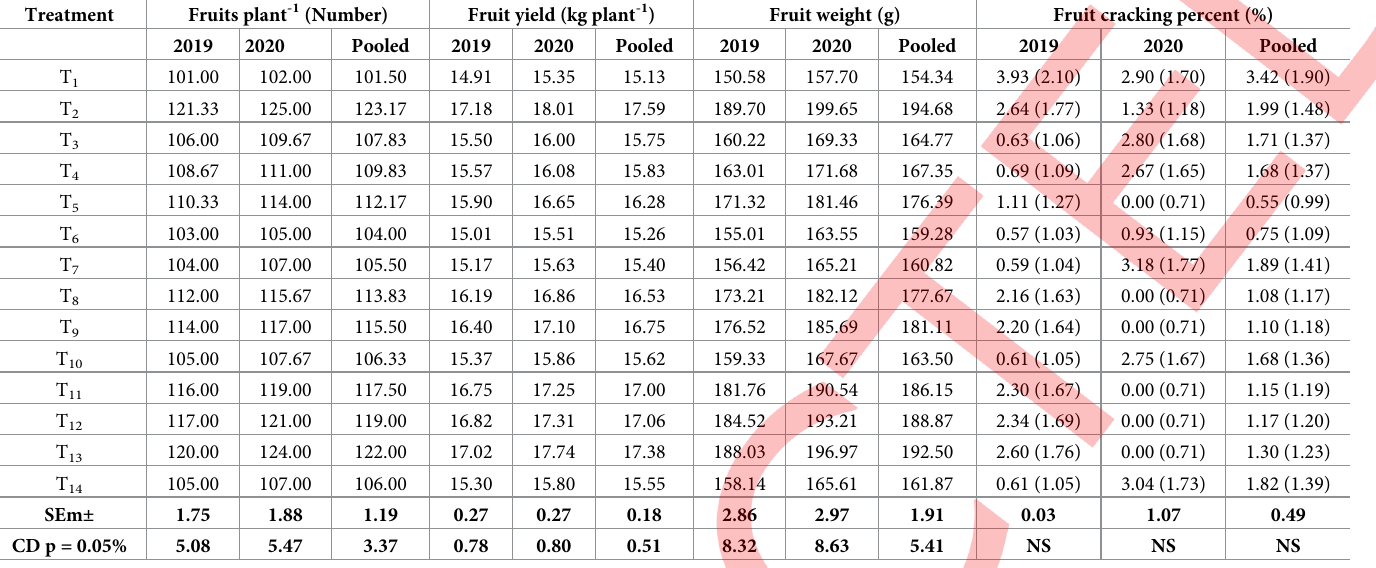
Table 3. Effect of organic manures on fruit quality characteristics of pomegranate cv. ‘Bhagwa’. Treatment Fruits plant -1